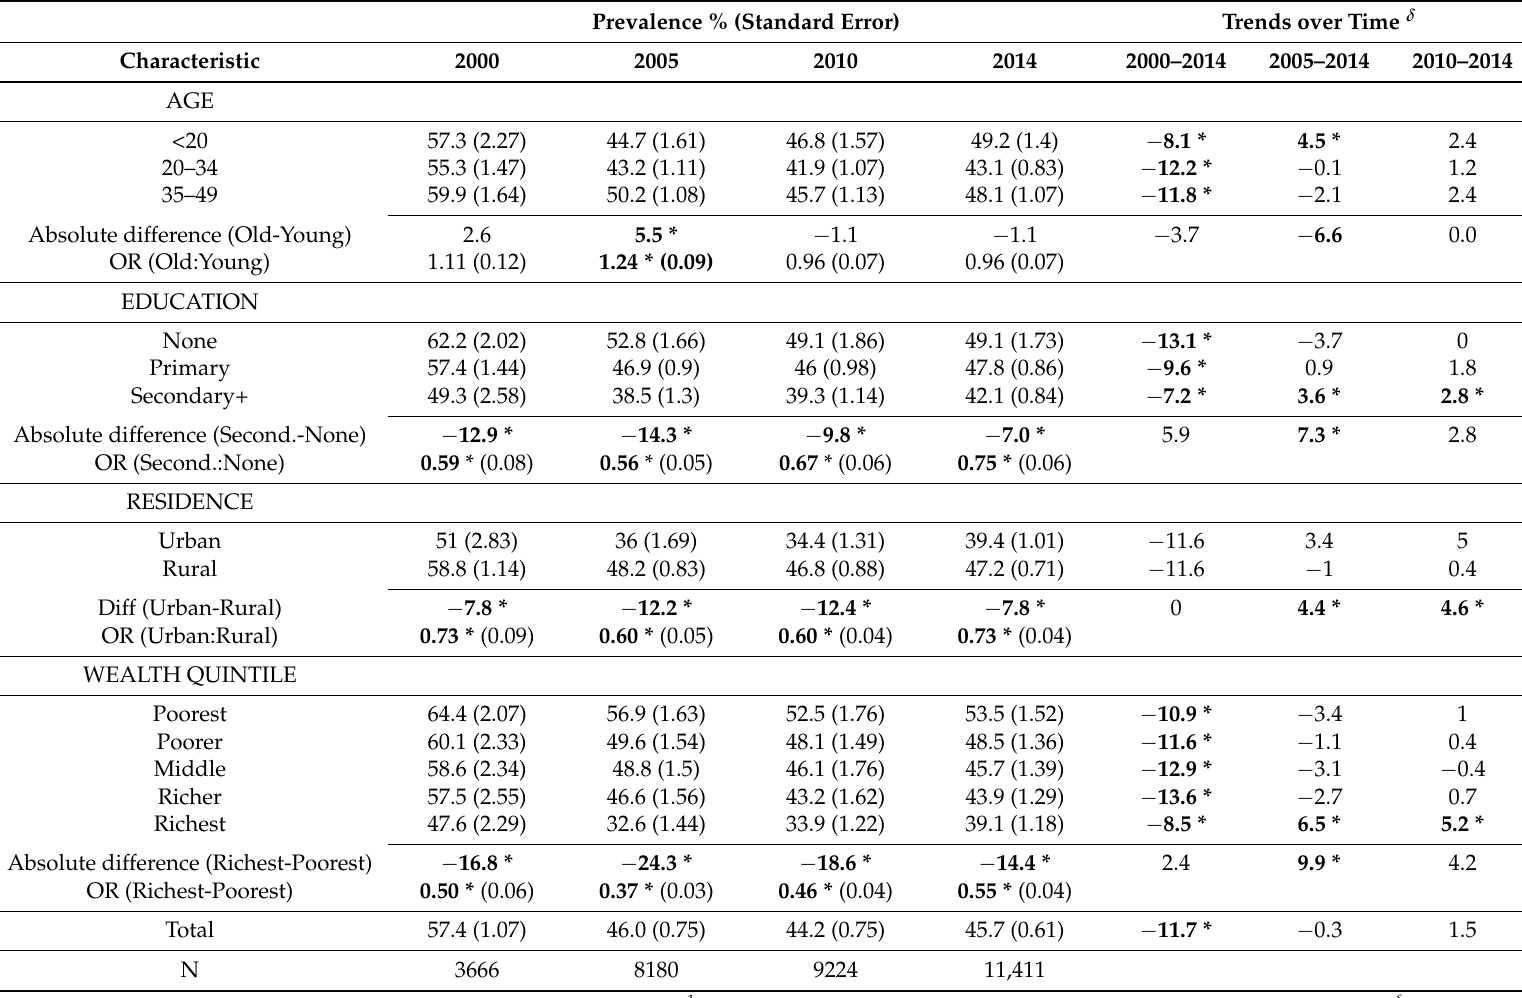
Table 4. Prevalence of anemia 1 in women according to their social